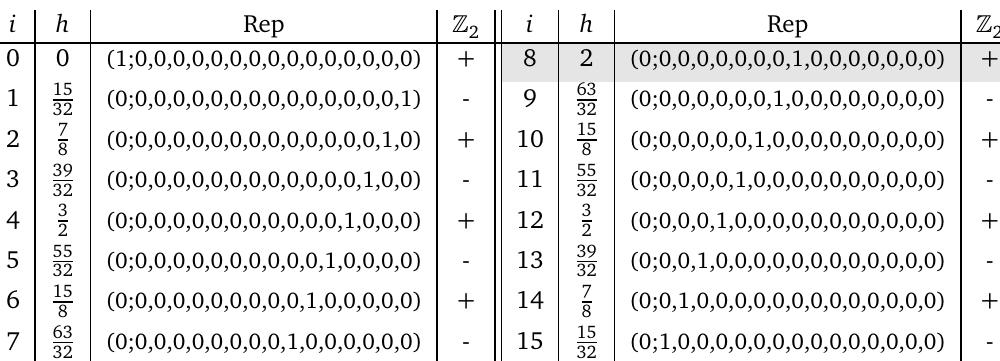
Table 24: SU ( 16 ) : primaries labeled by i are characterized by weights h and SU ( 16 ) Dynkin la- 1 ( τ ) . We highlight the primary related to the (cid:90) bels. Their characters are denoted by χ i of the center symmetry (cid:90) . 16